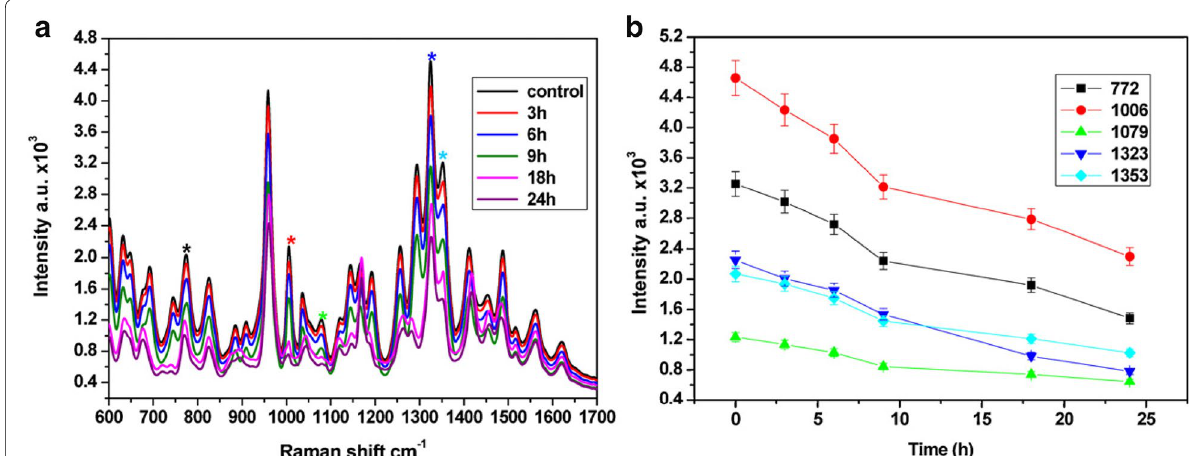
Fig. 7 a SERS spectra of living HepG2 cells exposed to 1 mM of hydroxyurea, 5‑fluorouracil, and cyclophosphamide, cells were treated for 24 h. b Changes in biochemical contents of Raman peaks from HepG2 cells treated with 1 mM of cyclophosphamide, 5‑fluorouracil, and hydroxyurea. Data represent the mean standard deviation of ten different experiments (Reprinted with permission from [38]. Copyright @ 2010 ±